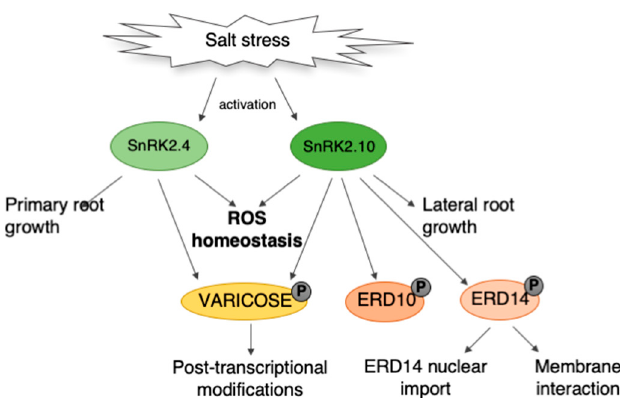
Figure 7. Schematic model illustrating the role of SnRK2.4 and SnRK2.10 in Arabidopsis’ response to salt stress. SnRK2.4 and SnRK2.10 modulate root growth under the salinity conditions. Moreover, in response to salt stress, the ABA-non-activated SnRK2s phosphorylate VARICOSE (VCS), a protein participating in mRNA decay, and two dehydrins, Early Responsive to Dehydration 10 (ERD10) and ERD14. Our results presented here revealed that SnRK2.4 and SnRK2.10 regulate the ROS homeostasis in the response to salinity.